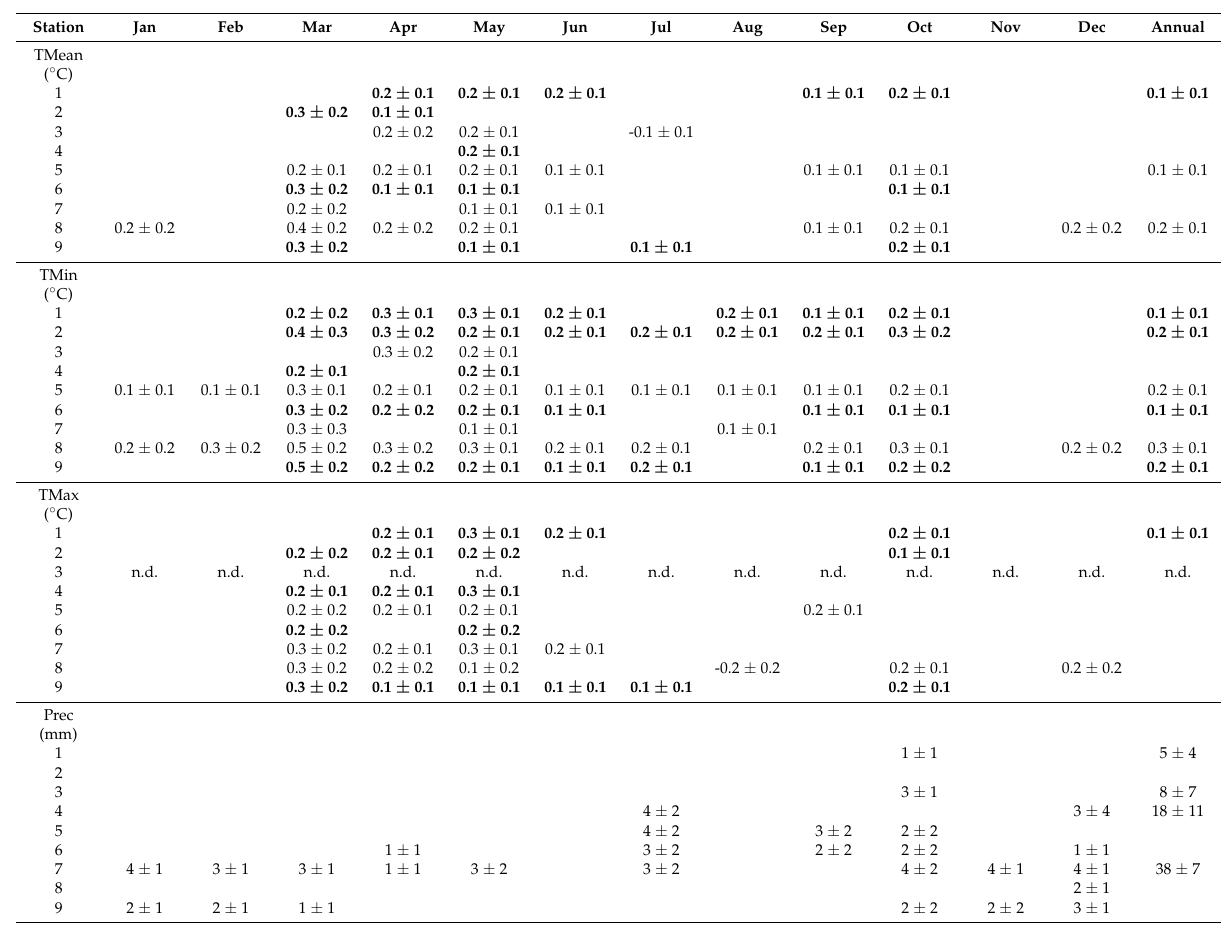
Table 2. Trends (p < 0.05) and the 95% confidence intervals over the period 1914–2013 for monthly and annual means of daily mean, minimum and maximum temperatures ( ◦ C/decade) and monthly and annual precipitation sums (mm/decade) using a least-squares method. Sen’s trend estimate produced nearly identical results (not shown in the table). Homogeneous stations (1, 6, 9) or stations with only isolated inhomogeneities (2, 4) are marked in bold. Blanks indicate the absence of statistically significant